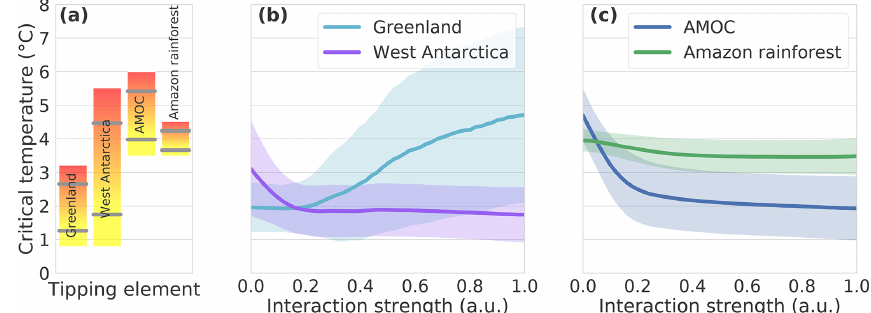
Figure 4. Shift of critical temperature ranges due to interactions. (a) Critical global mean surface temperatures for each of the four inves- tigated tipping elements without taking interactions into account (as reproduced from the literature; Schellnhuber et al., 2016). Grey bars indicate the standard deviation arising when drawing from a random uniform distribution between the respective upper and lower temper- ature limits. These bars correspond to the critical temperature ranges in case of zero interaction strength in panels (b) and (c) . Change in critical temperature ranges with increasing interaction strength for the Greenland Ice Sheet and West Antarctic Ice Sheet ( b ) and the Atlantic Meridional Overturning Circulation (AMOC) and the Amazon rainforest ( c ). The standard deviation of the critical temperatures for each tipping element within the Monte Carlo ensemble is given as respective coloured shading.